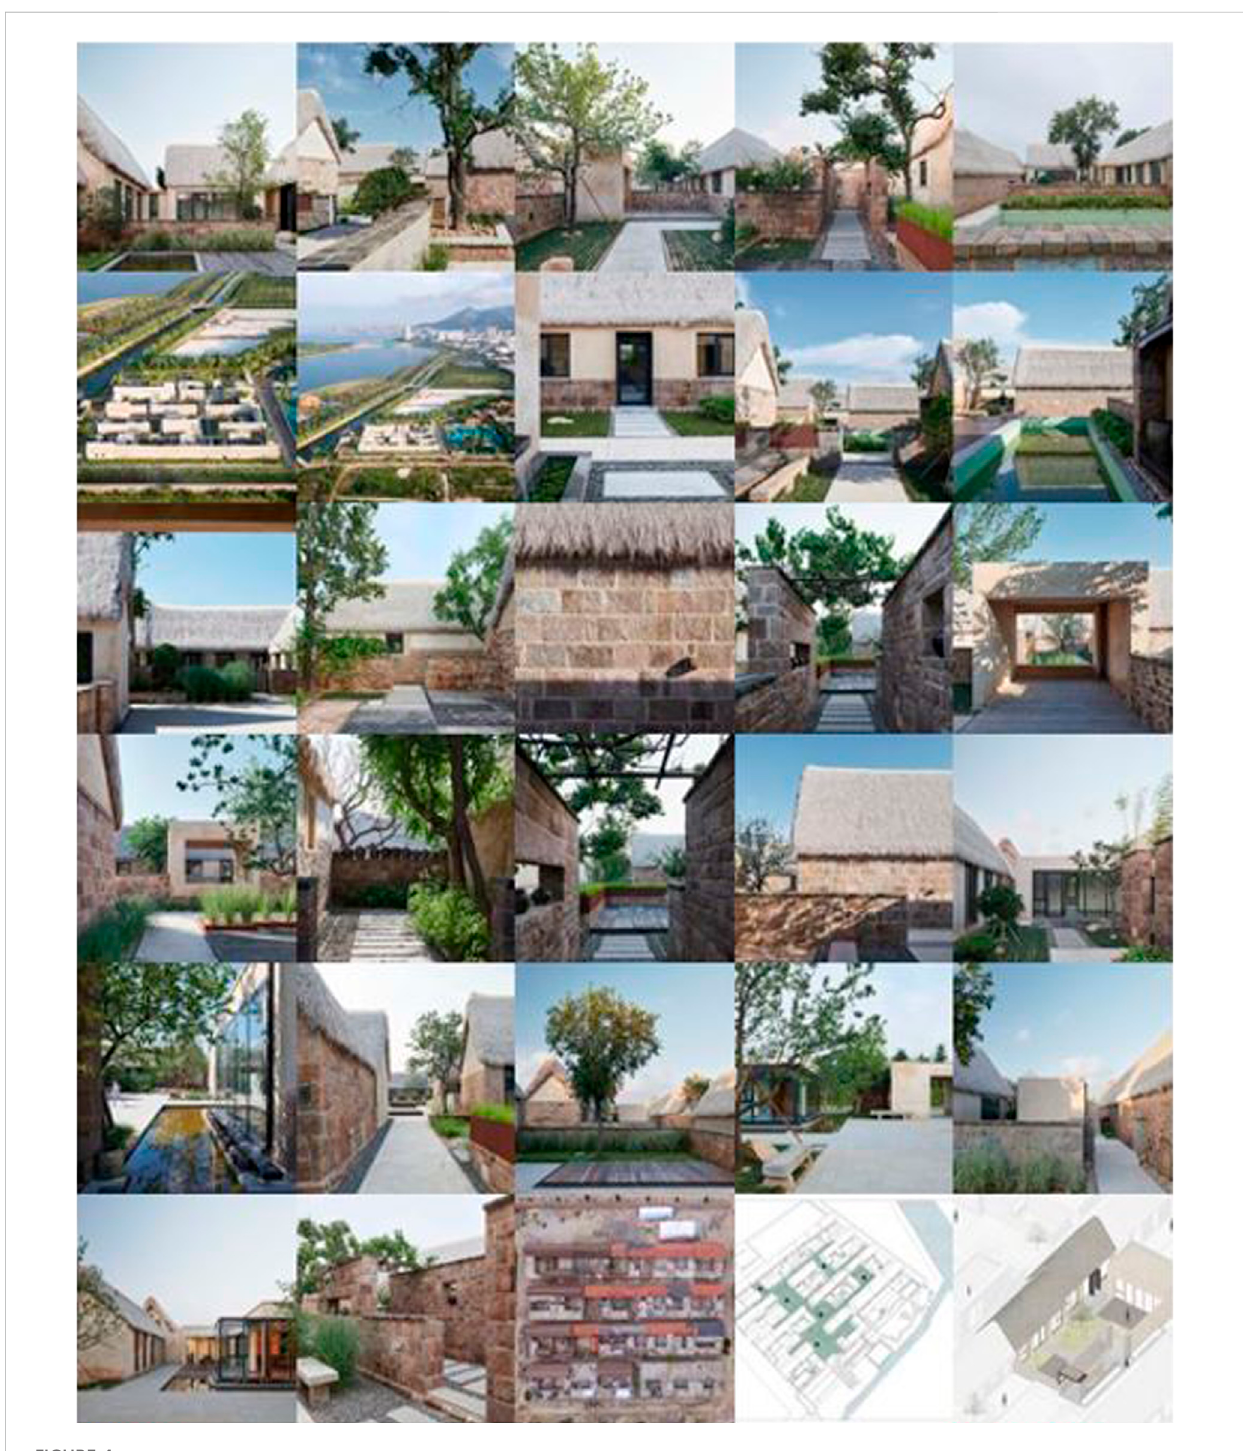
FIGURE 4 Photoproduction of Seaweed Bay health Resort, China; Source: Ekhaese and Ndimako (2022).